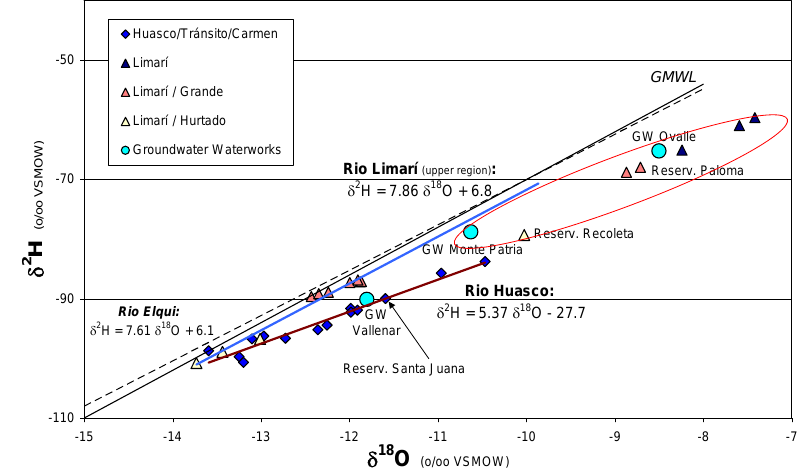
Fig. 3. Isotopic signature of the water components of the both catchments within the δ 2 H- δ 18 O diagram. The water line of the Huasco catchment comprises all tributaries. For the Limar´ı catchment, only run-off of the mountain tributaries forms the water line (blue line). Lower region is evaporation influenced (red area). To compare: Global Meteoric Water Line (GMWL δ 2 H=8 δ 18 O+10) and Rio Elqui water line (dotted) are added (see Strauch et al., 2006).